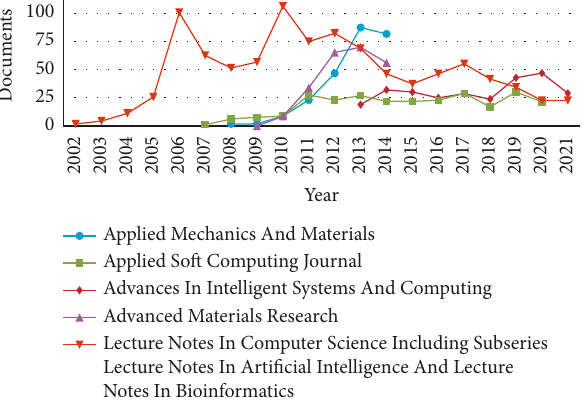
Figure 4: Top journal sources for publications in PSOA research